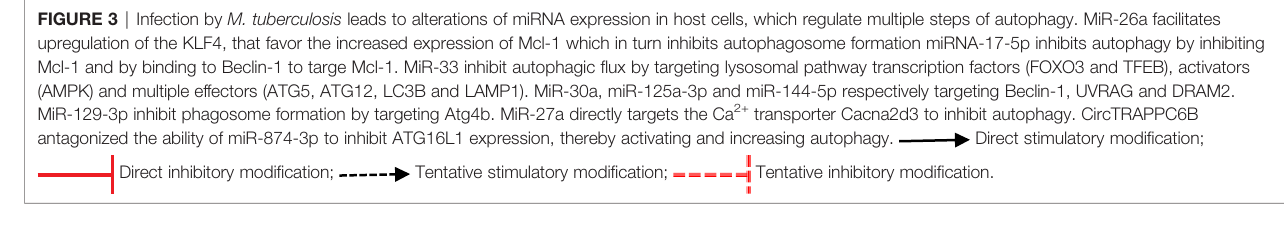
TABLE 3 | MiRNA-mediated regulation of autophagy during M. tuberculosis infection. MiRNA Regulation MiRNA-target predictions and validation plat- (Express) form/assay